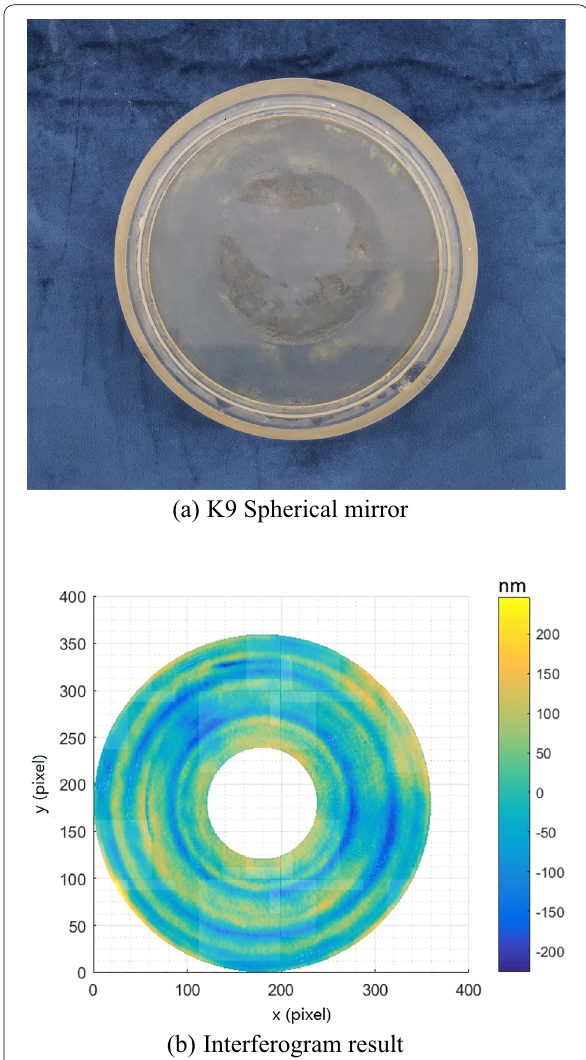
Figure 12 The result of the polished mirror (the plus and minus signs represent the position relative to xy